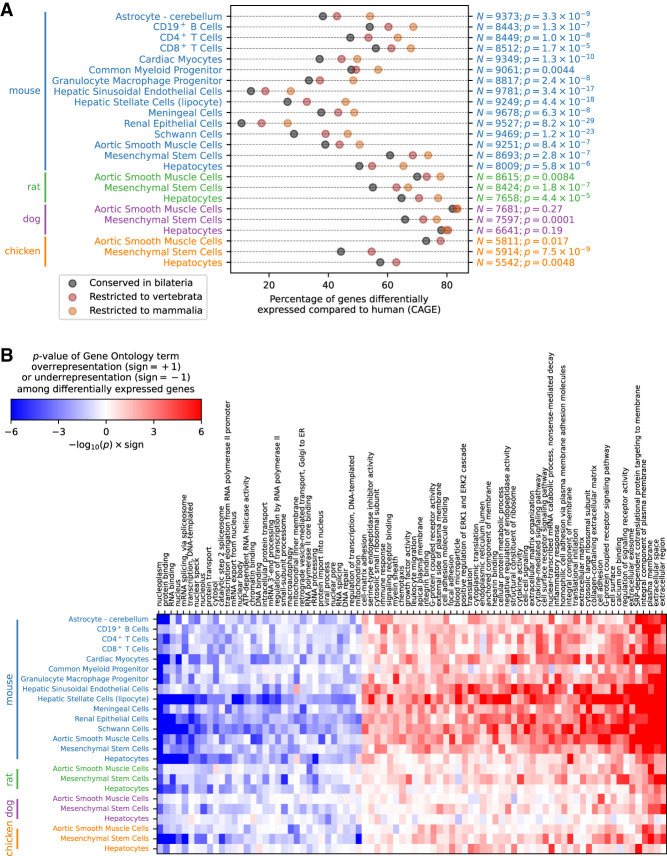
Conservation and Gene Ontology analysis of differentially expressed genes. (A) Percentage of differentially expressed genes in each cell type as a function of age of the most recent common ancestor. The one-sided P-value of a Poisson regression model against the evolutionary age category is shown on the right, together with the number N of expressed genes in each cell type with an annotation in the NCBI HomoloGene database. (B) Gene Ontology analysis of differentially expressed genes. The P-value, calculated using Fisher's exact test, of overrepresentation or underrepresentation of differentially expressed genes in each Gene Ontology category compared to an expression-matched set of background genes is shown in red and blue, respectively.